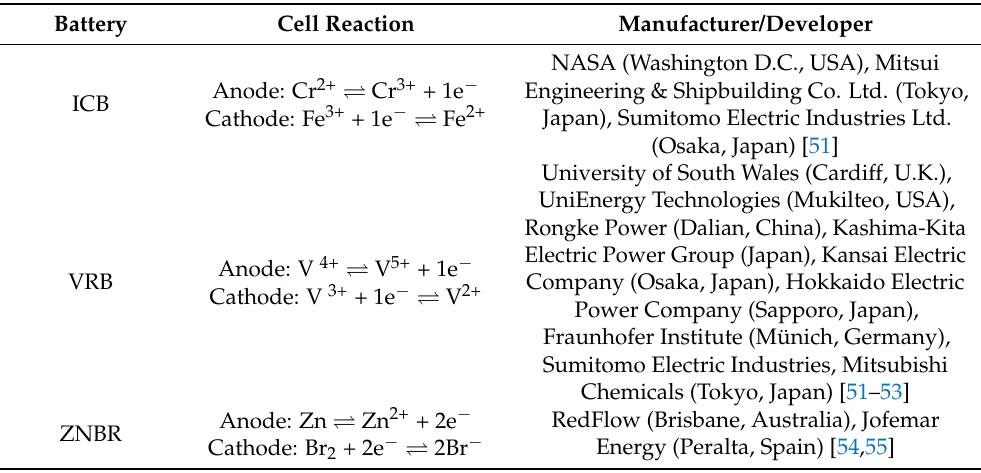
Table 7. Redox Flow Batteries. Characteristics and